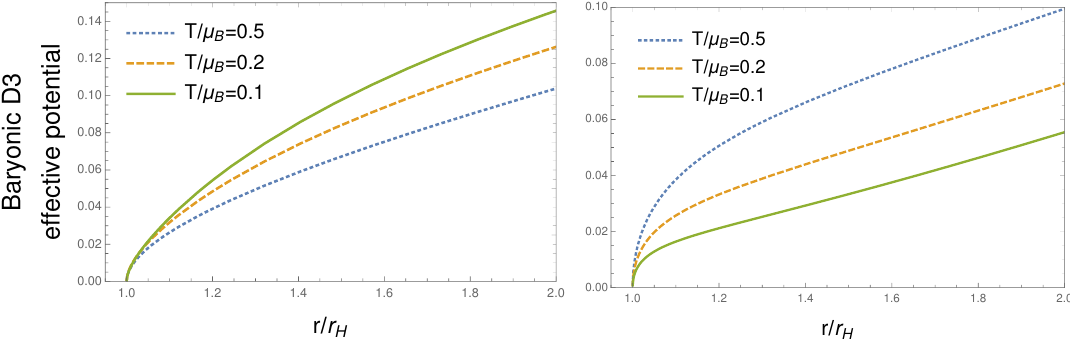
Figure 7 . The e(cid:11)ective potential for a probe baryonic D3-brane wrapped around the S 3 parametrized by f (cid:18) 1 ; (cid:30) 1 ; g (left) and f (cid:18) 2 ; (cid:30) 2 ; g (right). The curves are all at T=M = 0 : 5, with varying T=(cid:22) B